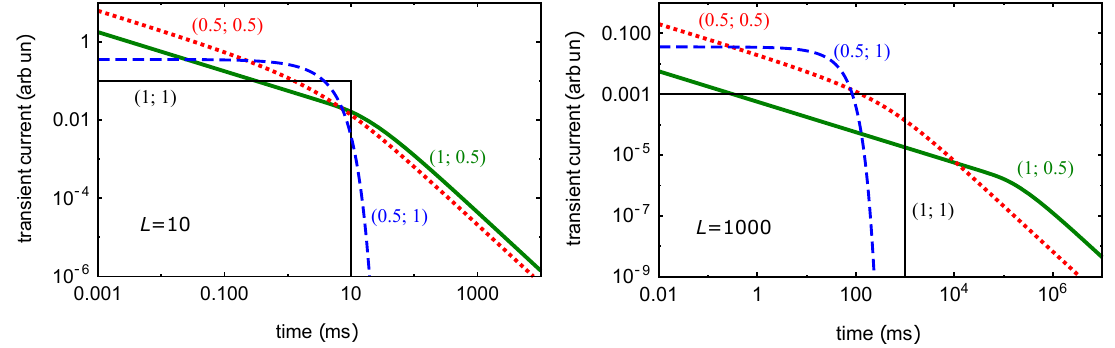
Figure 2. Transient current curves for different pairs ( α ; β ). ( Left ) L = 10; ( right ) L =